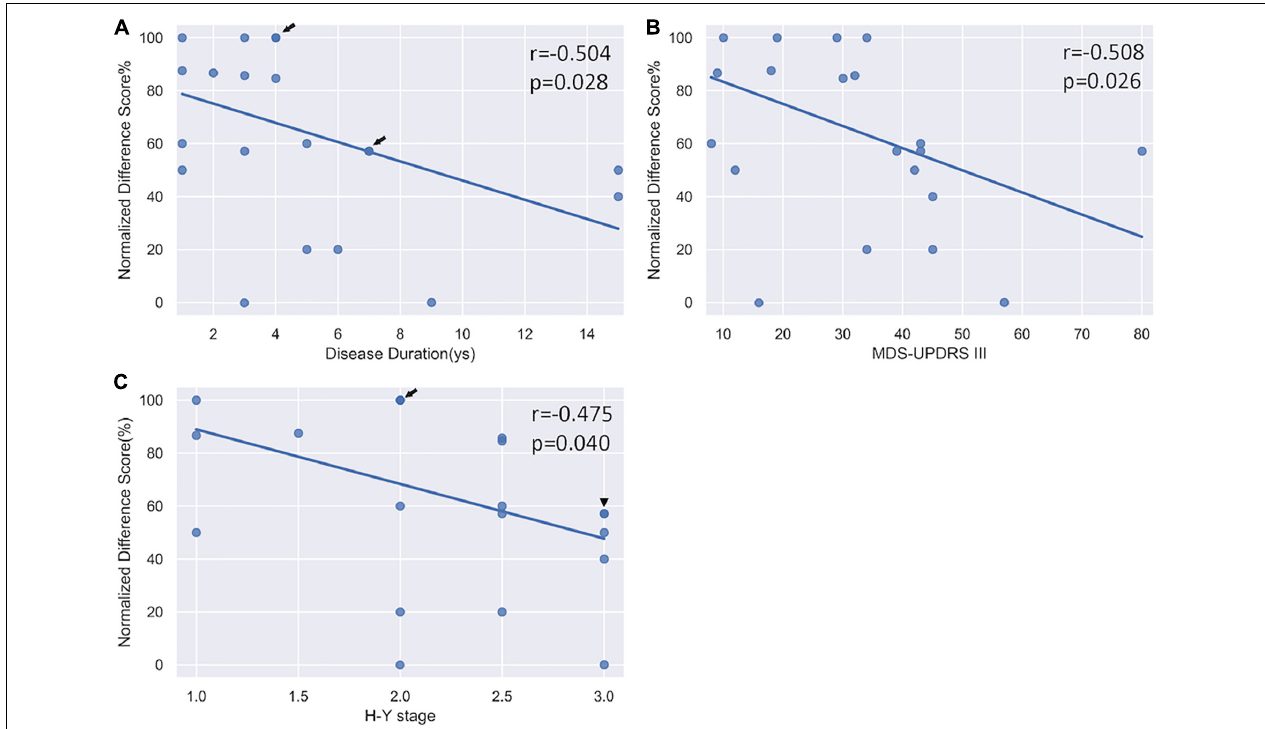
FIGURE 4 | Correlation analysis between the normalized differential score and clinical severity. (A) A significant negative correlation with disease duration. (B) A significant negative correlation with MDS-UPDRS III scores. (C) A significant negative correlation with H-Y stage. Arrow indicates there are two subjects sharing the same value; triangle indicates there are three subjects sharing the same value.